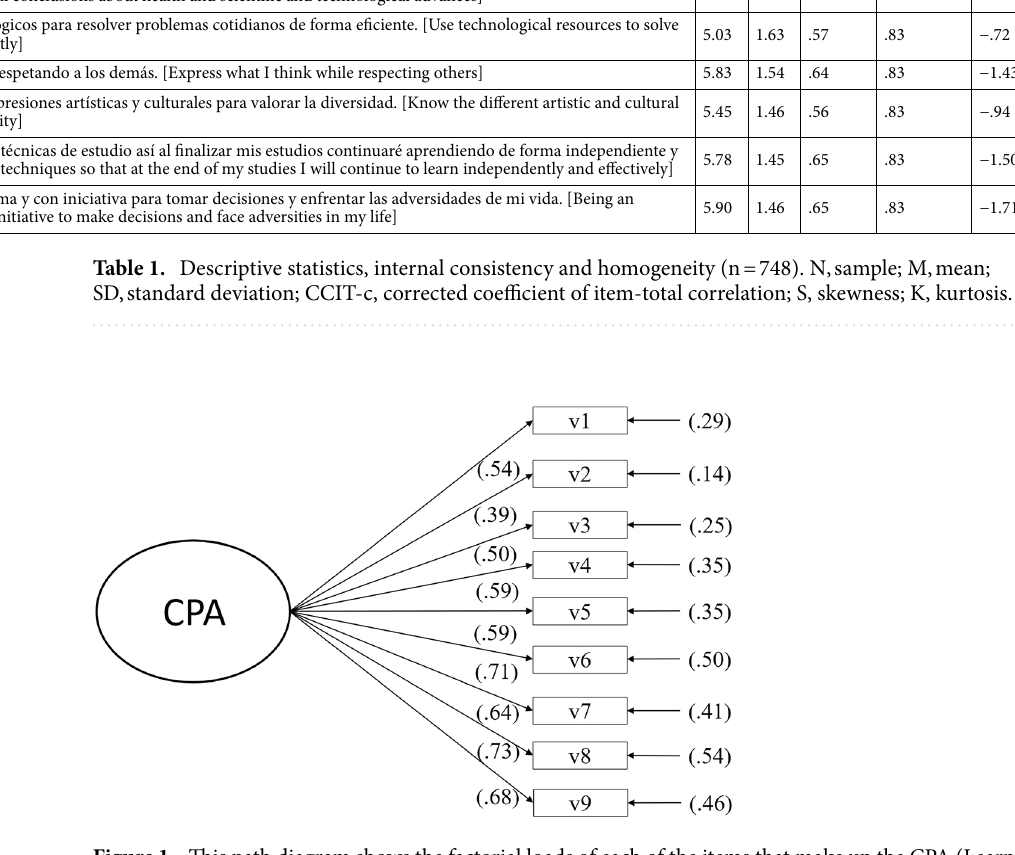
Figure 1. This path diagram shows the factorial loads of each of the items that make up the CPA (Learning Perception Questionnaire)